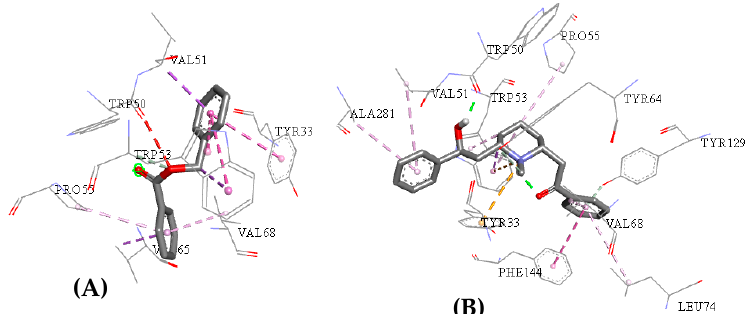
Figure 9. Interactions between the active site of juvenile hormone with the molecules ZINC00001021 ( A ) and ZINC00001624 ( B ).